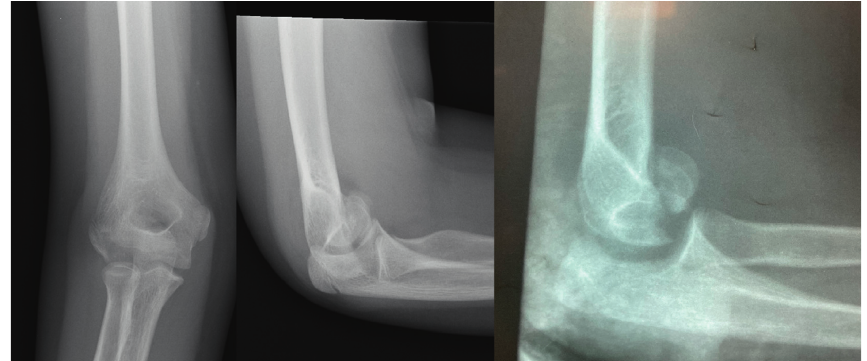
Figure 4: Patient number 1, posttraumatic X-rays, and control lateral view after 3 weeks from